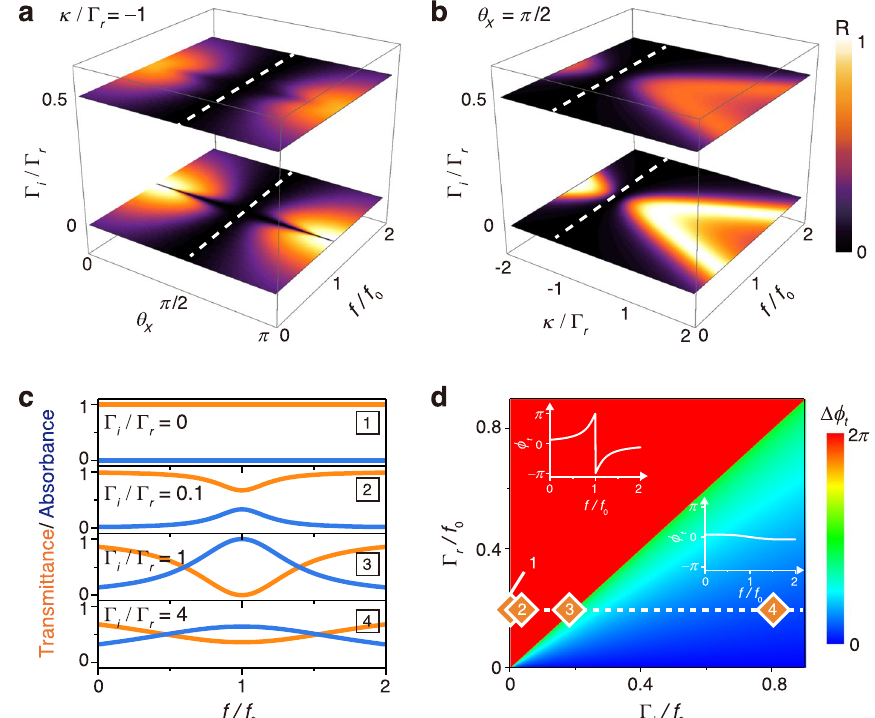
Fig. 3 Influences of Γ i on the optical properties of the model satisfying Eq. (4). a Reflectance of the model system versus frequency and θ X in the cases of Γ i /Γ r 0 and Γ i /Γ r 0.5, respectively, with κ /Γ r fixed as 1. b = = − Reflectance of the model system versus frequency and κ /Γ r in the cases of Γ i /Γ r 0 and Γ i /Γ r 0.5, respectively, = = with θ X fixed as π /2. c Calculated spectra of transmittance (orange lines) and absorbance (blue lines) of the model systems with κ /Γ r 1 and θ X π /2, and with Γ i /Γ r taking 4 different values. d Transmission phase = − = coverage of the model system versus Γ i / f 0 and Γ r / f 0 . Four symbols labeled with #1–4 correspond four cases studied in c . Upper and lower insets depict the calculated spectra of transmission phase for the systems labeled with #1 and #4, respectively. In all cases studied, we have Γ r / f 0 =